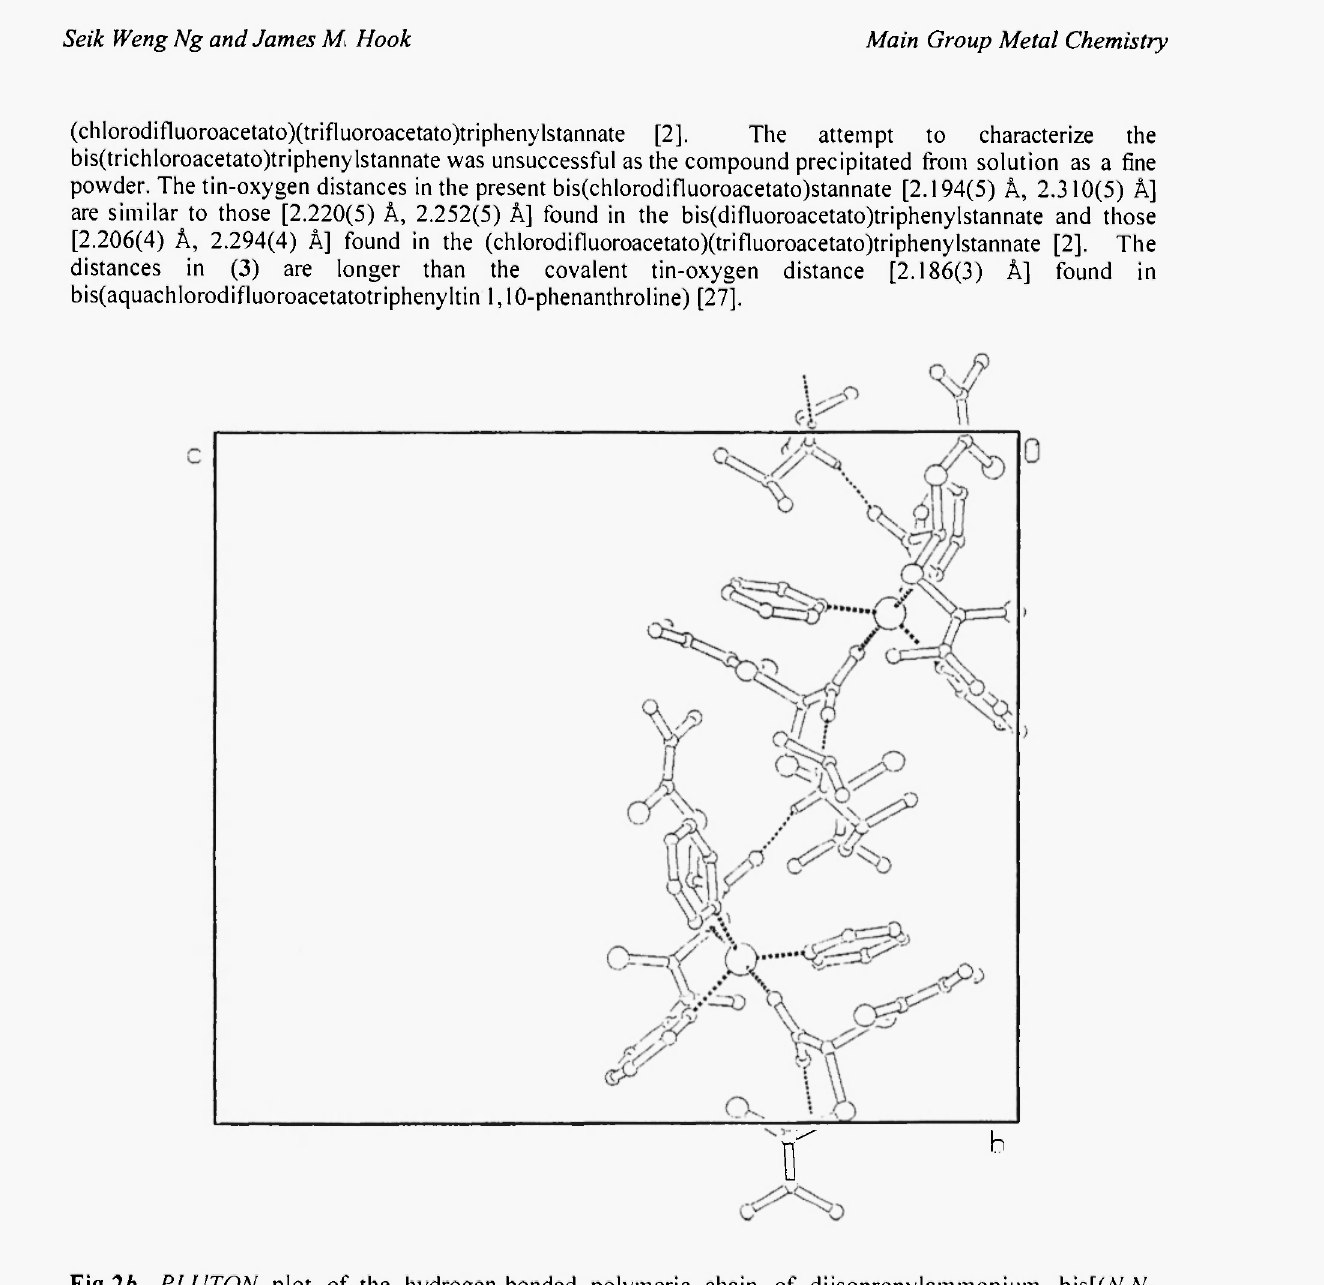
h Β Fig.2Z>. PLUTON plot of the hydrogen-bonded polymeric chain of diisopropylammonium bis[(/V,/V- dimethyldithiocarbamoyl)acetato]triphenylstannate projected along the α-axis of the unit cell. Hydrogen bonds: N5 02 = 2.780(5), N5 04' 2.950(6) A. Symmetry transformation / = 0.5 - .v, 0.5 + v, 1.5 - r. The Sn NMR resonances of the dicyclohexylammonium bis(trifluoroacetato)triphenylstannate (1), tetramethylammonium bis(trifluoroacetato)triphenylstannate [1] and diisopropylammonium bis[(/V,/V- dimethyldithiocarbamoyl)acetato]triphenylstannate (2) appear at -300±40 ppm relative to t^tramethyltin,